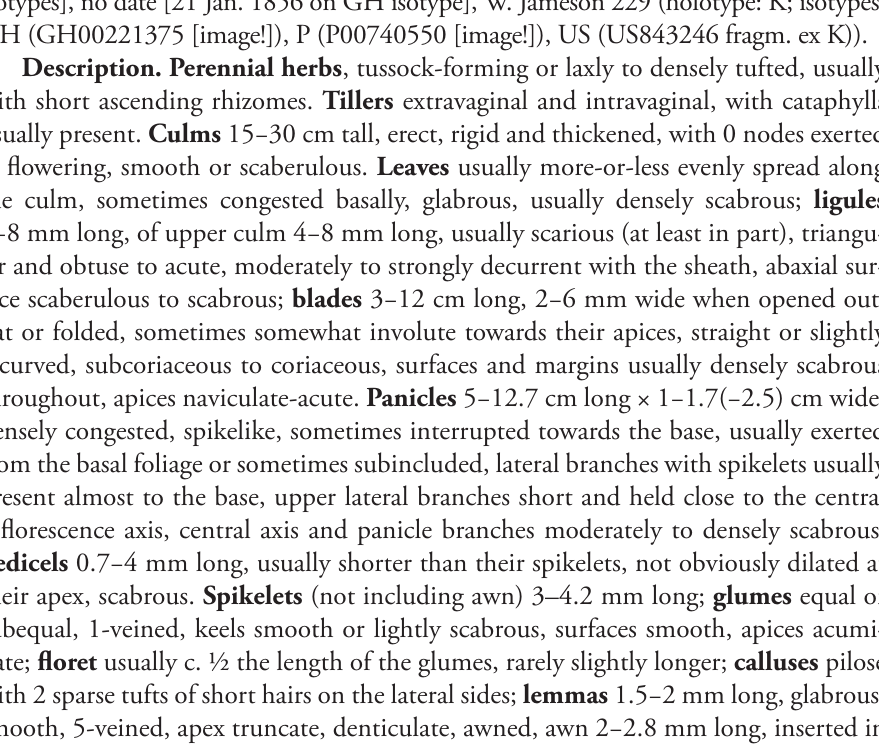
= Agrostis nigritella Pilg., Bot. Jahrb. Syst. 25 (5): 713–714. 1898. Type: Ecuador. Chimborazo: in páramos montis Antisana ad Cerro de la Media Luna, 4400 m alt., no date, M.A. Stuebel 231 (holotype: [not found]; isotype: US (US75324 fragm.)). = Agrostis stuebelii Pilg., Bot. Jahrb. Syst. 25 (5): 714. 1898. Type: Colombia. Toli- ma: in monte ignivomo Tolima fere ad nivis limitem adscendens, no date, Stuebel 198 (lectotype, designated here: US ex B (US00902474!); isolectotype: US ex B (US00902473!)). Syntype: Colombia. In monte ignivomo Purace copiose,